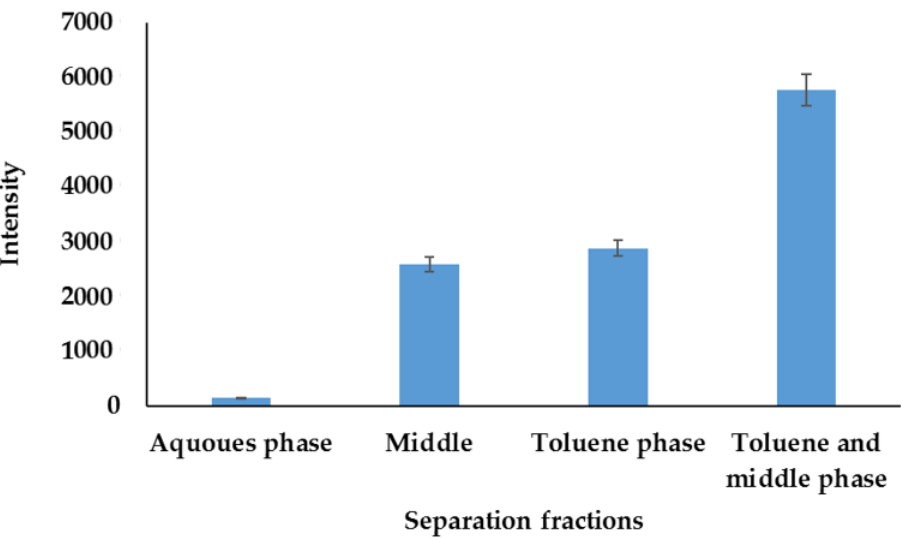
Figure 10. AuNP partitioning in organic, middle, and aqueous phase .